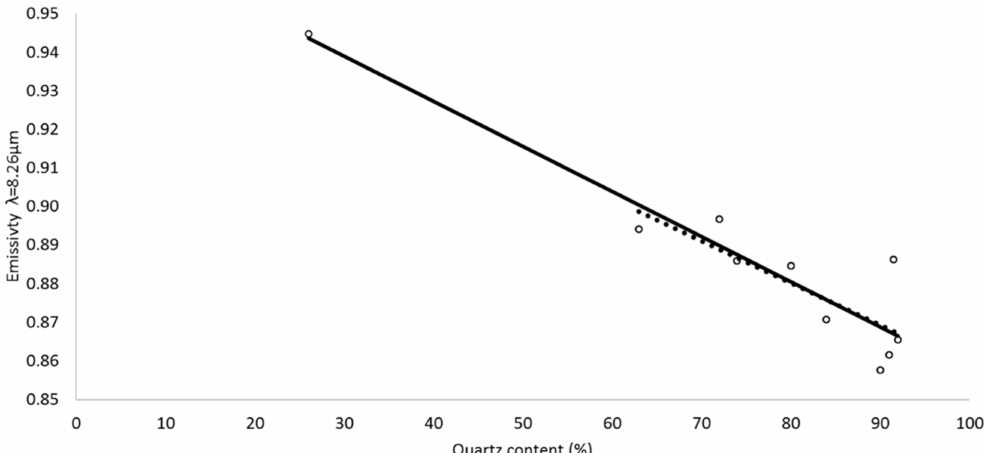
Figure 7. Quartz content determined by XRD analysis of 10 samples collected in the field and their corresponding apparent emissivity values at 8.26 µ m extracted from the AisaOWL image. R 2 = 0.88, p < 0.05, and slope = − 0.0012 were calculated for the linear regression line through all of the samples (solid) and R 2 = 0.61, p < 0.05, and slope = − 0.0011 for just nine points, excluding the playa sample with the low quartz content